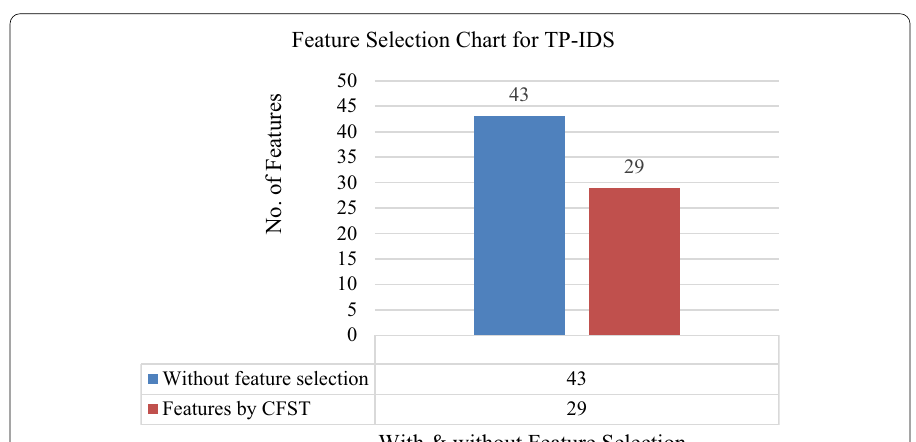
Fig. 6 Feature selection